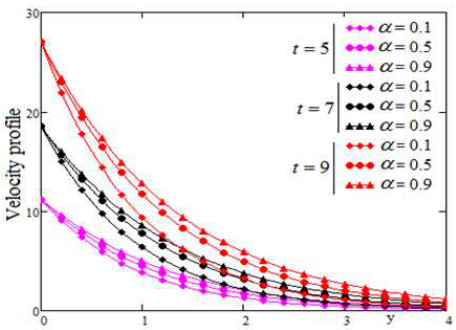
Figure 2. Profile of dimensionless velocity versus y for α variation with Pr = 0 . 7 , S = 5 , Sc = 0 . 8 , λ = 4 , Gr = 3 , Gm = 0 . 9 , M = 0 . 4 and different large values of time t